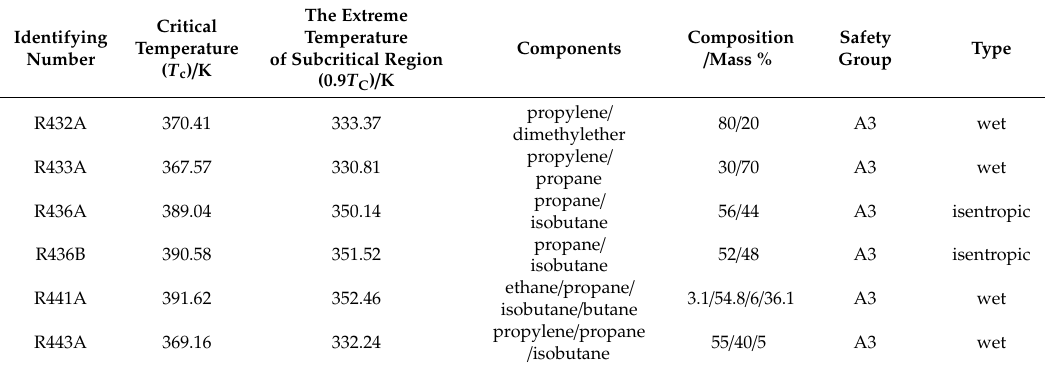
Table 3. Main thermodynamic and safety properties of six zeotropic mixtures.